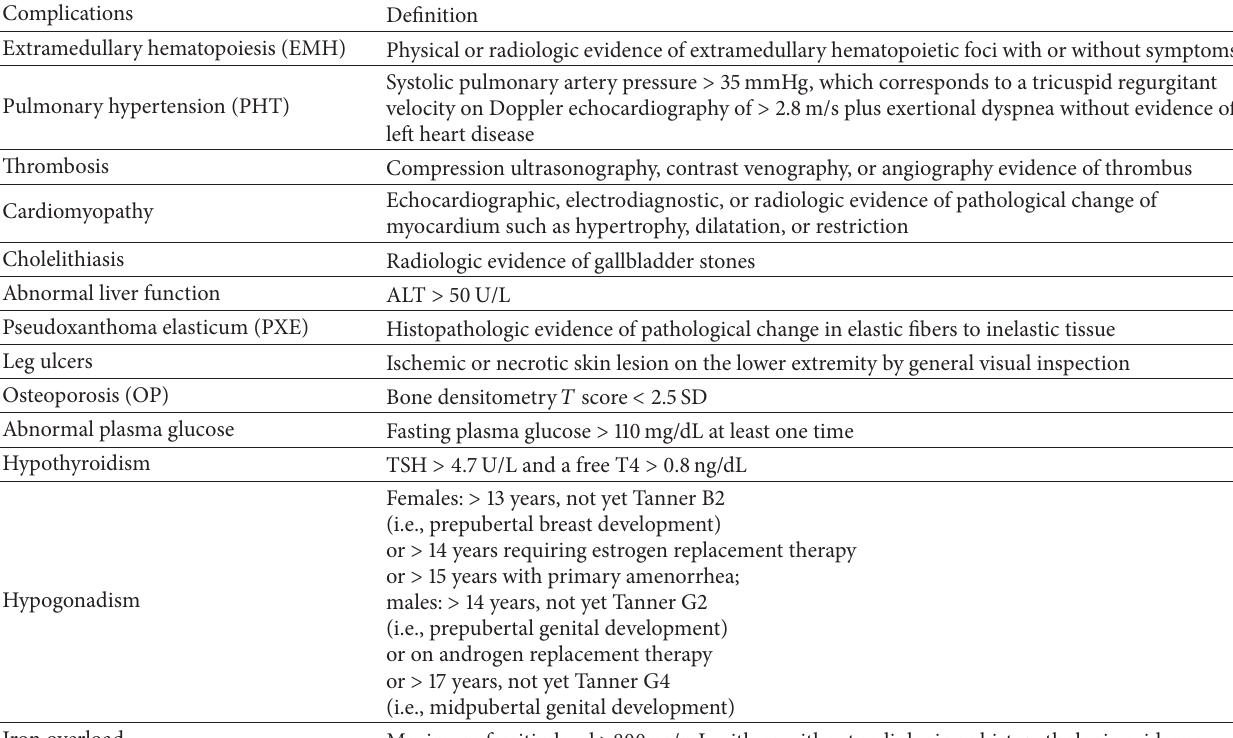
Table 1: Clinical definition required to confirm identified